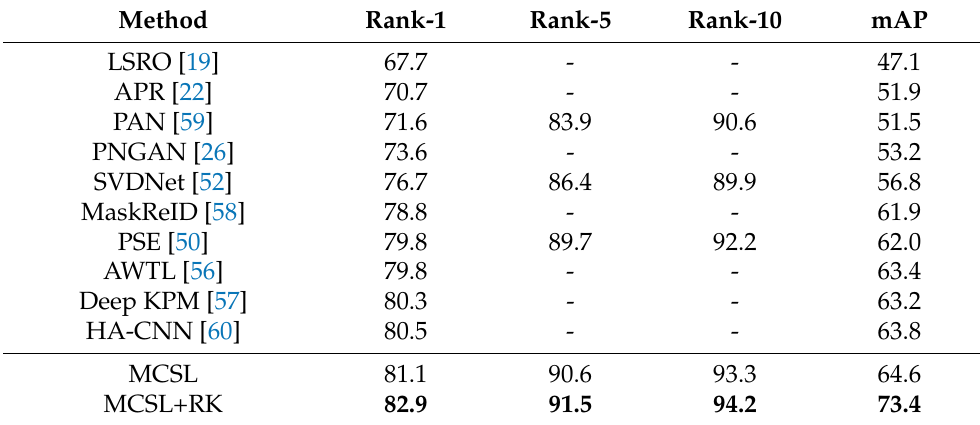
Table 4. Comparisons of rank-1, rank-5, rank-10, and mAP with different methods on the DukeMTMC-reID dataset. Bold fonts denote the highest